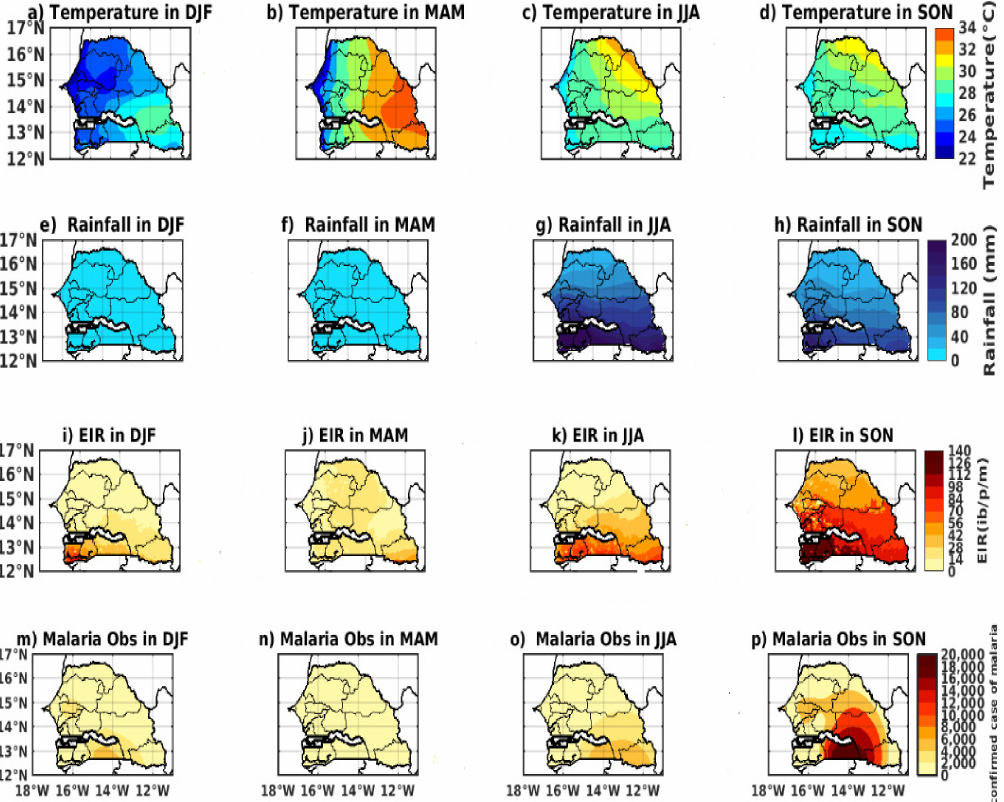
Figure 12. Comparison of the spatial variability between the data of the number of confirmed cases of malaria and EIR in agro-climatic zones in Senegal from 2009–2019: temperature in DJF ( a ), MAM ( b ), JJA ( c ), SON ( d ); rainfall in DJF ( e ), MAM ( f ), JJA ( g ), SON ( h ); EIR in DJF ( i ), MAM ( j ), JJA ( k ), SON ( l ); and malaria cases in DJF ( m ), MAM ( n ), JJA ( o ), SON ( p